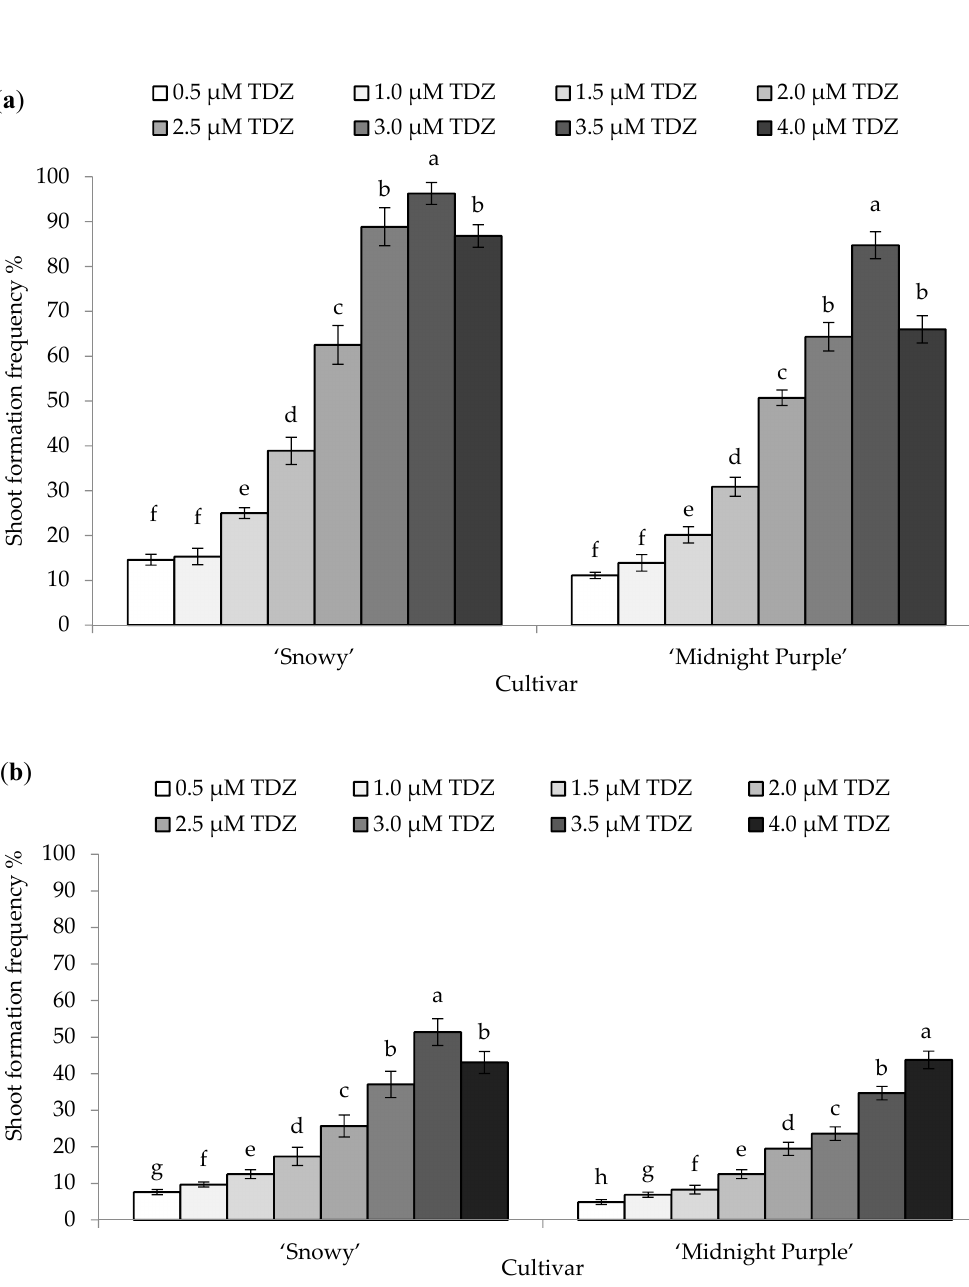
Figure 2. Effect of thidiazuron (TDZ) concentration on gloxinia shoot formation frequency. Means ± SE of cultivars followed by the same letter were not significantly different at p < 0.01. (( a )—adaxial side down, ( b )—abaxial side down).